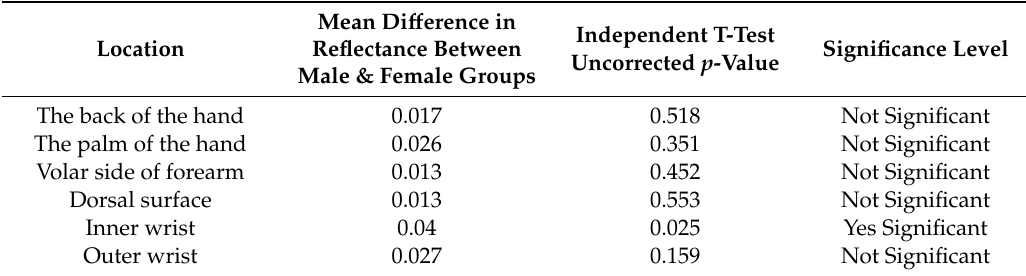
Table 3. Significance level of the mean di ff erences in the reflectance values between both sexes groups.